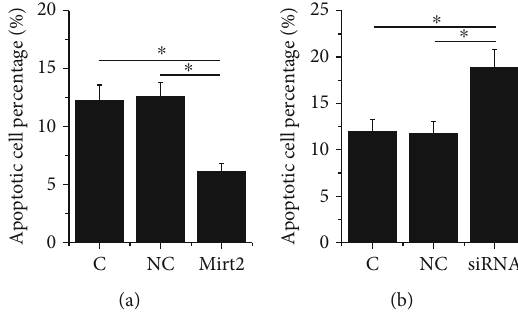
Figure 4: Mirt2 inhibited HCnEpC apoptosis under LPS treatment. Cell apoptosis data analyzed by one-way ANOVA and the Tukey test showed that, comparing C and two NC, Mirt2 overexpression led to decreased (a), while Mirt2 siRNA silencing led to increased (b) apoptotic rate of HCnEpCs ( ∗ p < 0 : 05